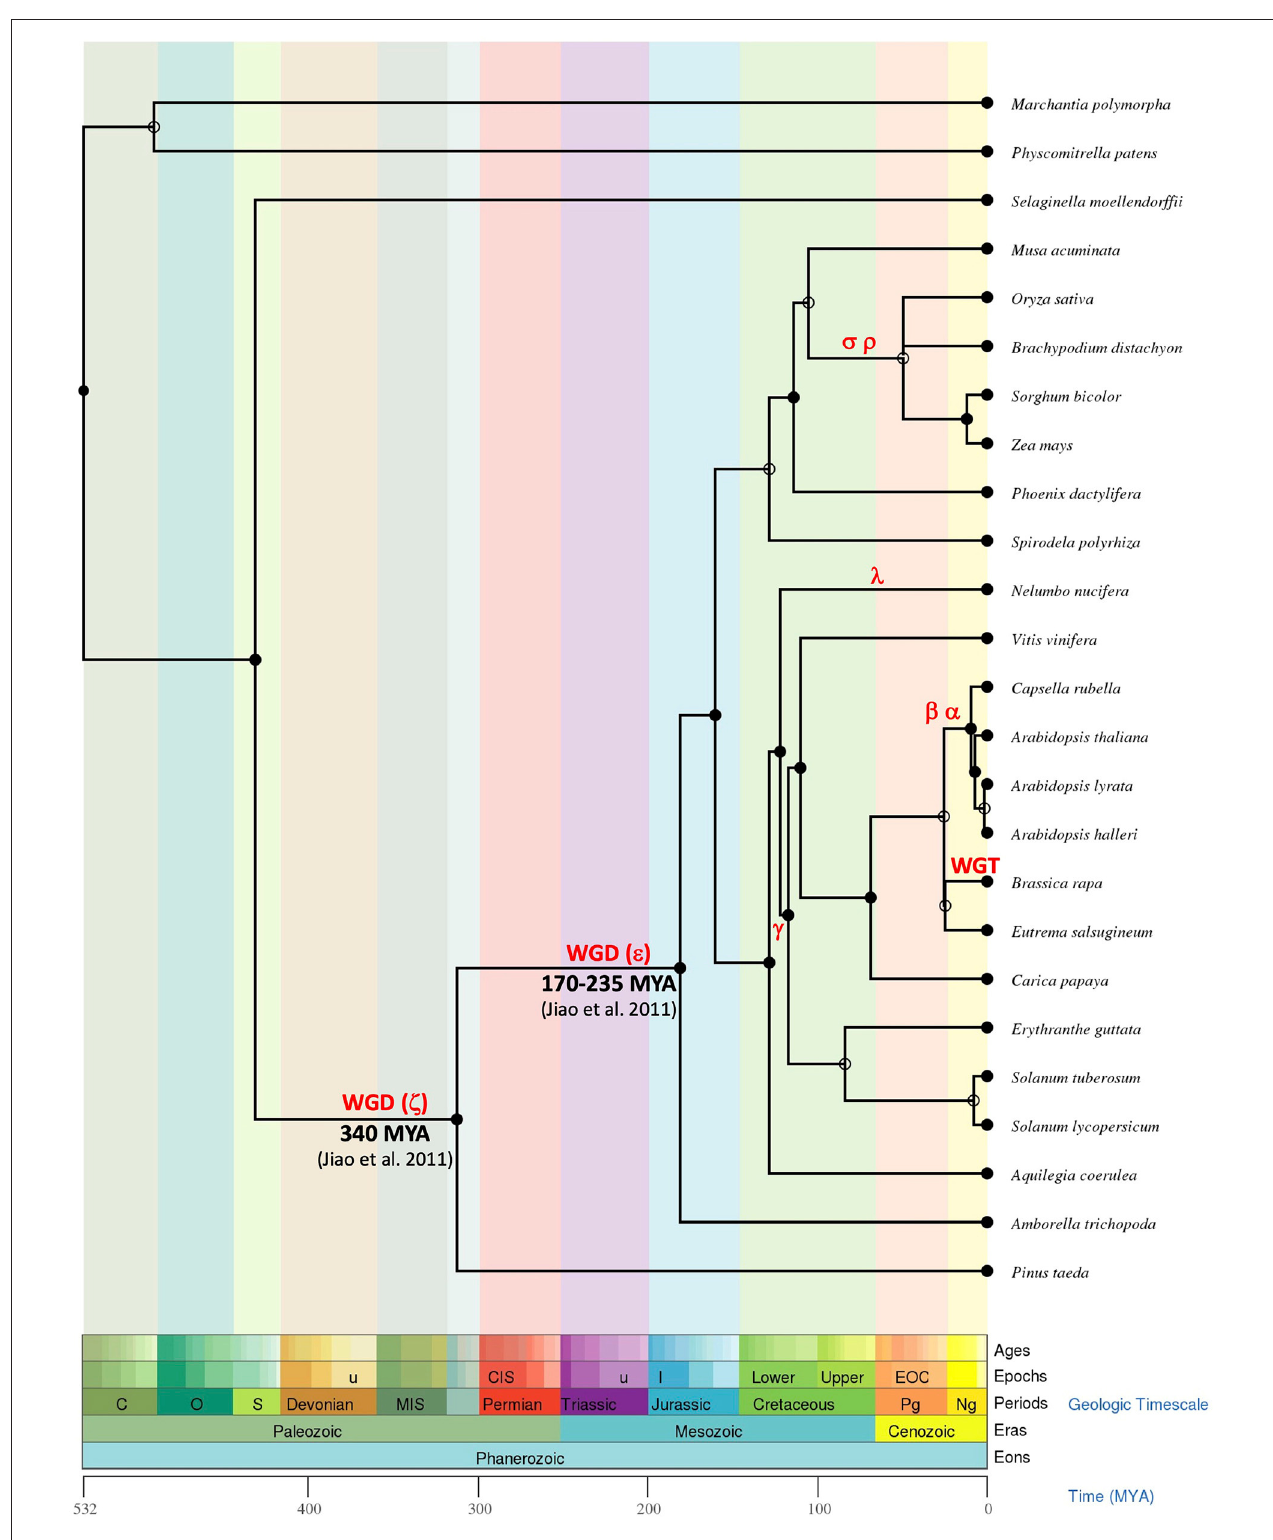
FIGURE 14 | The phylogenetic tree inference of the evolution of ESL genes in the plant kingdom. All dates, periods, and evolutionary data used to rebuild the evolutionary history of the ESL family through the evolution of land plants were obtained from the Time Tree of Life (http://www.timetree.org, Hedges et al., 2006; Kumar et al., 2017). For readability reasons, only the most striking species have been considered. Major duplication events are indicated according to the literature.